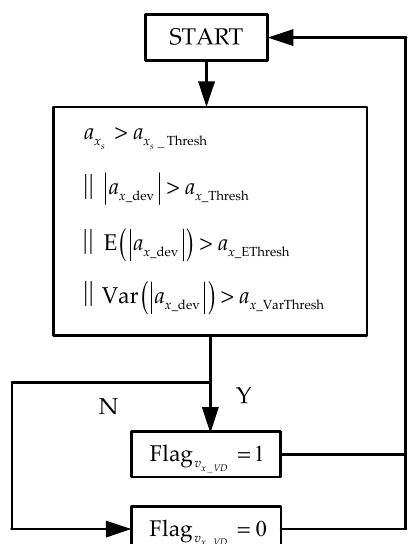
Figure 3. Feedback mechanism for longitudinal velocity and pitch angle estimator. a x _dev is the deviation between VDM-based and fused longitudinal acceleration; E means expectation; Var means variance for a short time; || means operation.